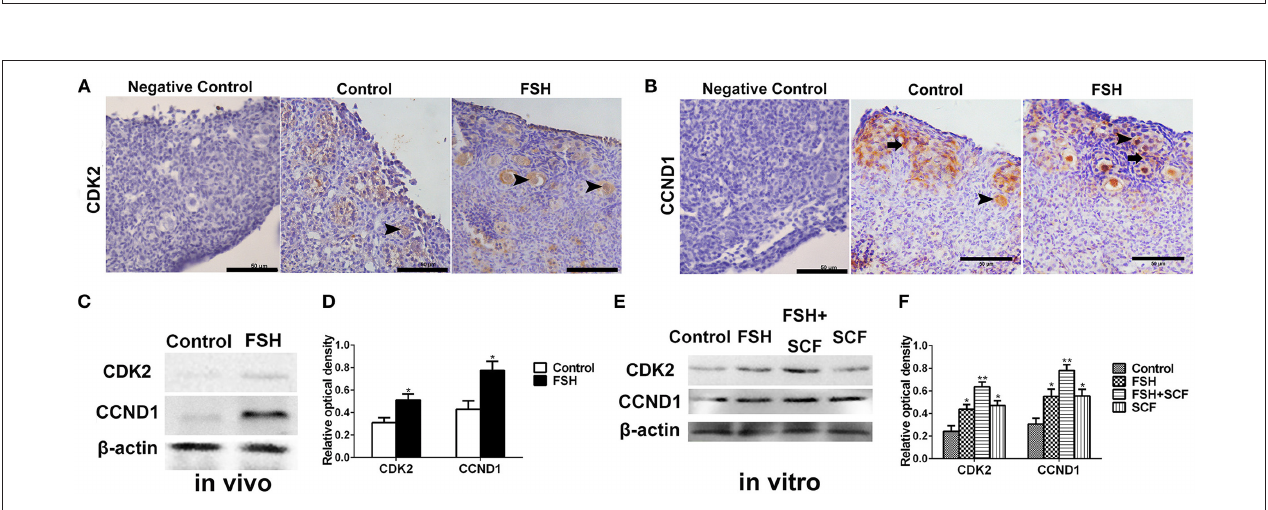
Frontiers in Endocrinology |